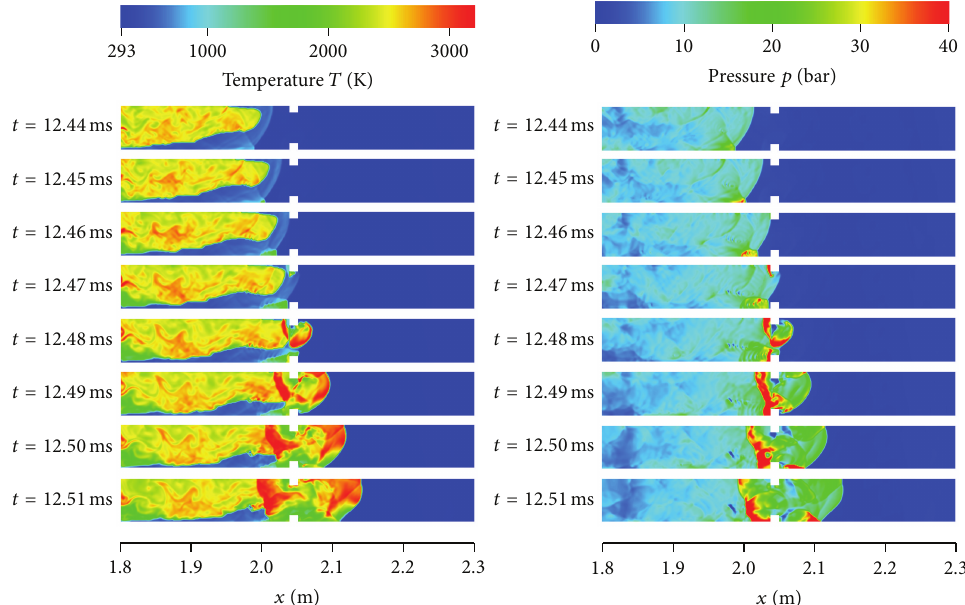
Figure 12: Visualization of a DDT in the vicinity of the final obstacle.